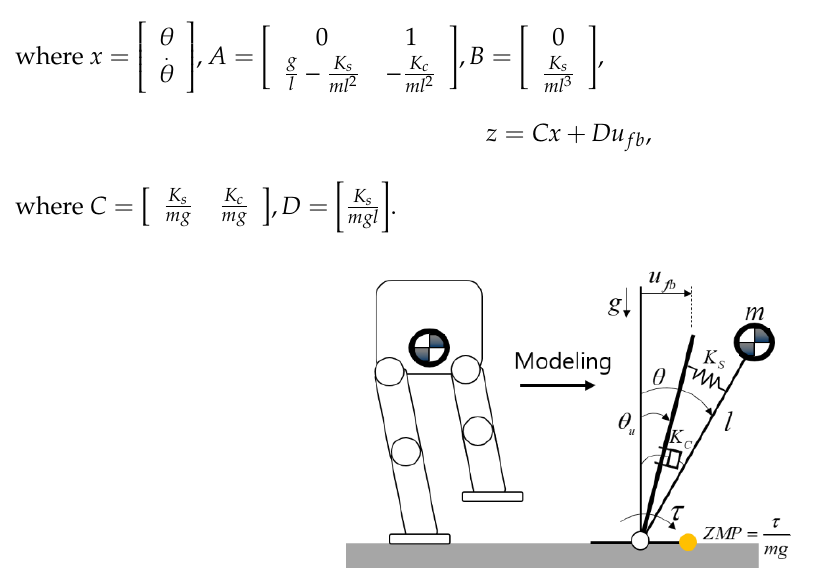
Figure 3. Inverted pendulum model with spring and damper.